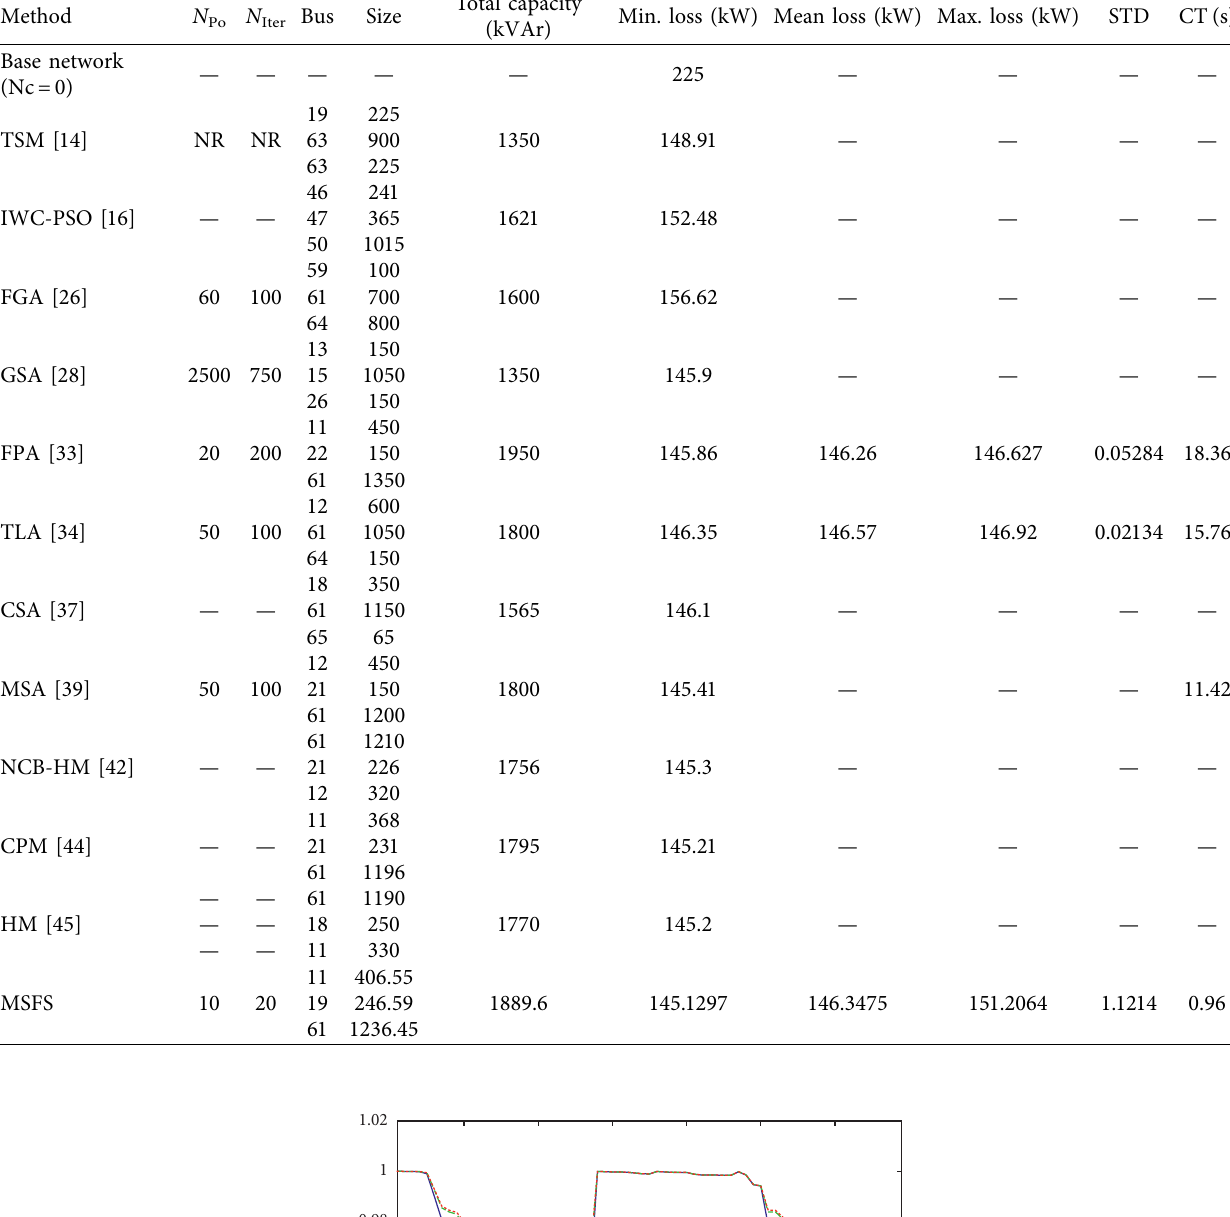
Table 6: Comparison with other methods for case 2 of the 69-bus system.